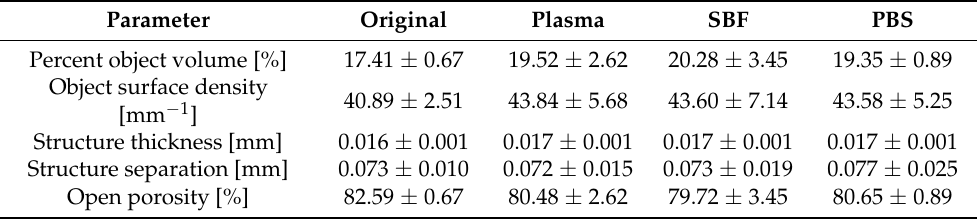
Table 1. Values of the selected parameters (mean, standard deviation, n = 20) determined via micro- CT analysis for the specimens prior to exposure (ORIGINAL) and following 14 days of exposure to the media: blood plasma (PLASMA), simulated body fluid (SBF), phosphate buffer saline